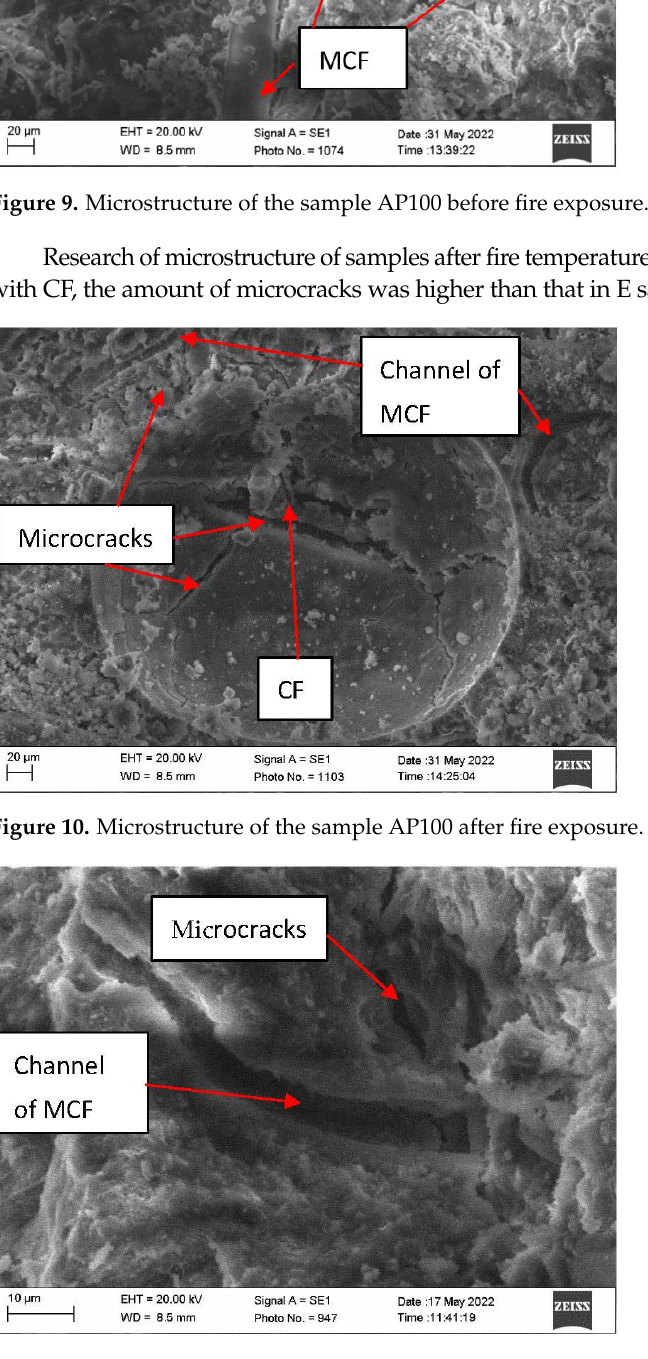
Figure 11. Microstructure of sample E after fire exposure. Research results showed that compressive strength of the samples AP050, AP075, and AP100 was higher than that of sample E (Figure 12). The highest compressive strength was determined in sample AP100, and was 7.3% higher than in sample E. Similar results were obtained in both the samples, AP050 and AP075. The determined compressive strength in these samples was accordingly 1.58% and 5.92% higher than in sample E. Therefore, changing the amount of CF in the samples from 0.5% to 1% compressive strength increased from 51.5 to 54.4 MPa when compared with sample E (50.7 MPa). After 30 min standard fire effect, compressive strength determination was carried out using the experiment samples. Compressive strength of the samples AP050, AP075, AP100 decreased in a similar range and were approximately from 49.5% to 66.7% lower com- pared to the results of the sample E. As the amount of CF in the samples varied from 0.5 to 1.0%, compressive strength of the samples after fire effect varied from 18.5 MPa to 12.2 MPa. Figure 12. Results of compressive strength (before and after fire effect) of the samples. Results of bending strength of the samples (Figure 13), as well as compressive strength results showed that bending strength of the samples AP050, AP075, AP100 was higher than sample E. The highest bending strength was determined in the samples AP050 as well and it was 14.9% higher than in sample E. Bending strength of the samples AP075 and AP100 was 8.5% and 6.4% higher respectively. Bending strength of the samples with CF (in natural conditions) was from 5.4 MPa to 5.0 MPa. After 30 min of standard fire effect, bending strength determination was carried out using the experiment samples. Bending strength of the samples decreased from 46.8% to 60.0% compared to the results of sample E. Decrement of bending strength of samples